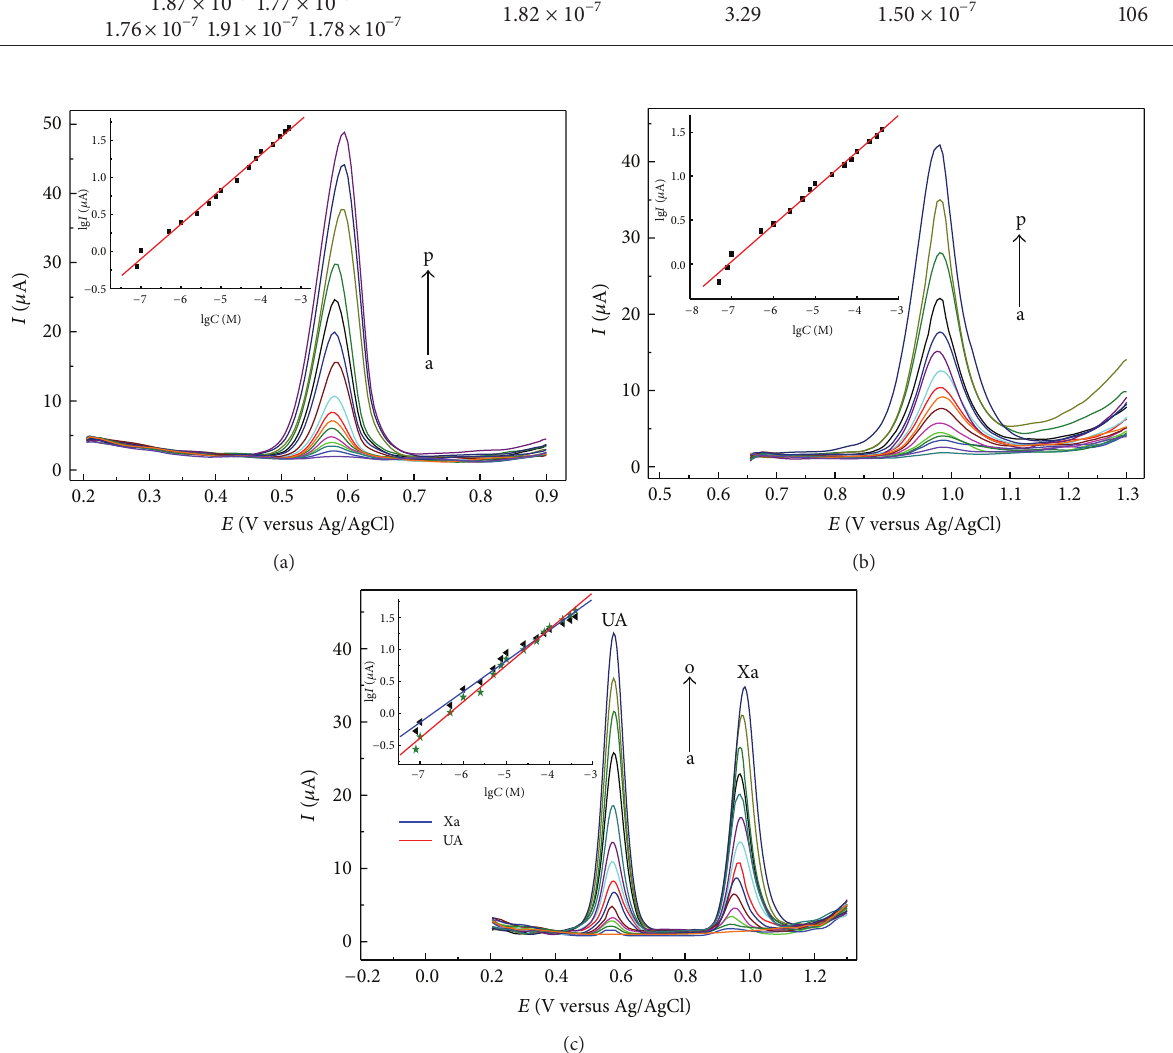
Figure 11: SWVs of different concentrations of UA (a) (from a to p: 0.08, 0.1, 0.5, 1, 2.5, 5, 7.5, 10, 25, 50, 75, 100, 200, 300, 400, 500 𝜇 M), Xa (b) (from a to p: 0.05, 0.08, 0.1, 0.5, 1, 2.5, 5, 7.5, 10, 25, 50, 75, 100, 200, 300, 400 𝜇 M), and the mixture solution of UA and Xa (c) (from a to o: 0.08, 0.1, 0.5, 1, 2.5, 5, 7.5, 10, 25, 50, 75, 100, 200, 300, 400 𝜇 M) with step 𝐸 for 5 mV, amplitude for 30mV, frequency for 5 Hz, and quiet time for 2 min. Insets show the calibration plots of lgI - lgC